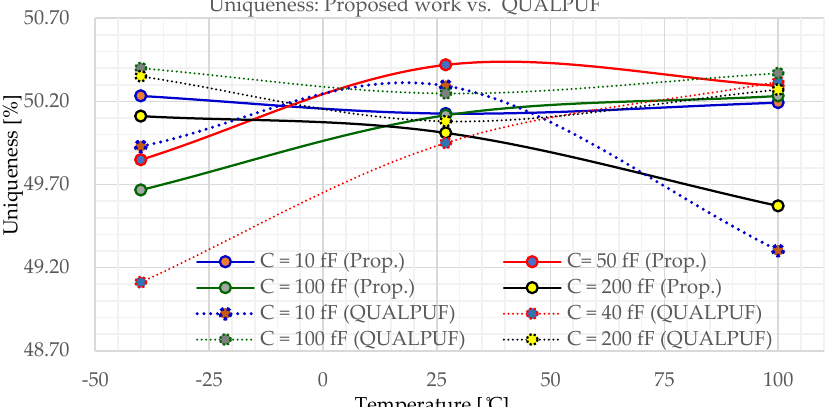
Figure 10. Uniqueness of the proposed adiabatic PUF (labeled as Prop.) versus QUALPUF under the TOX variation (4-bit PUF).